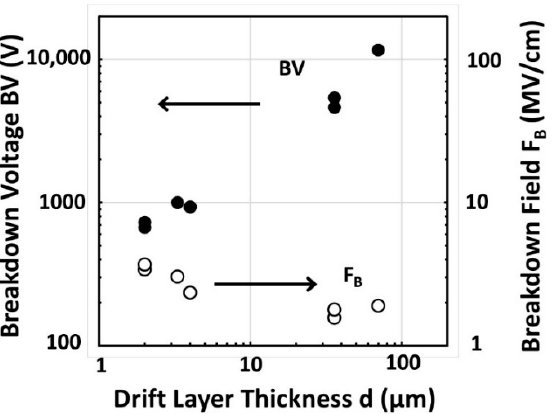
Figure 9. Reverse I–V properties for diamond PiN diode both with mesa structure and without mesa structure (drift layer thickness 36 µm).